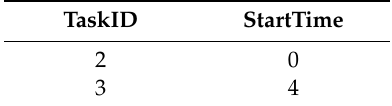
Table 4. Hi-criticality mode dispatch table for the task set example in Table